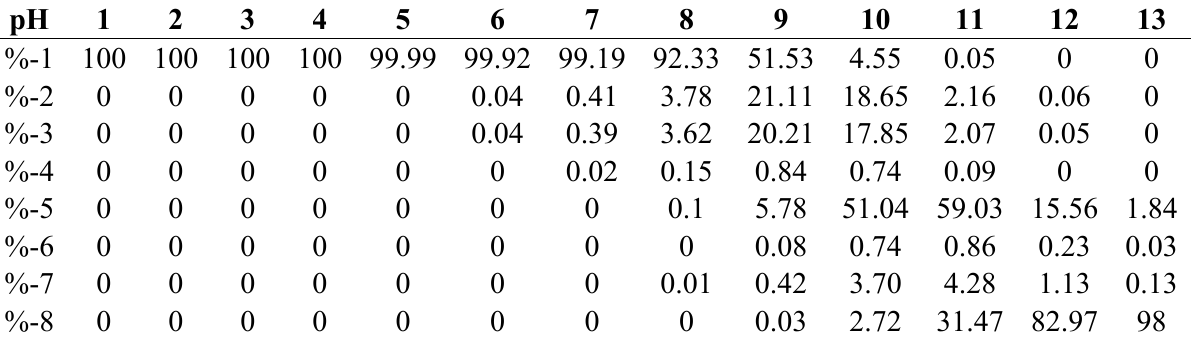
Table 2. Percentage of ionization of HCT depending on pH.